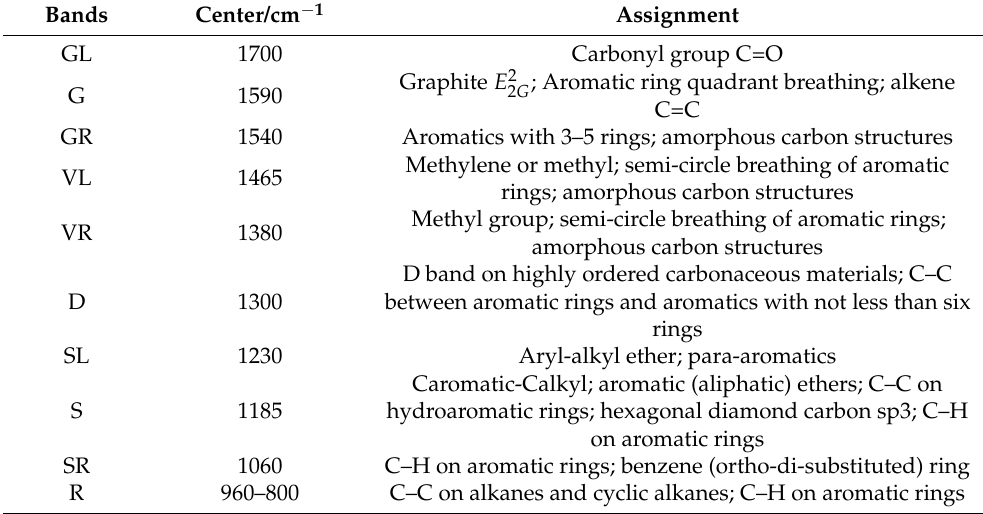
Table 2. Summary of the peak assignment [63].